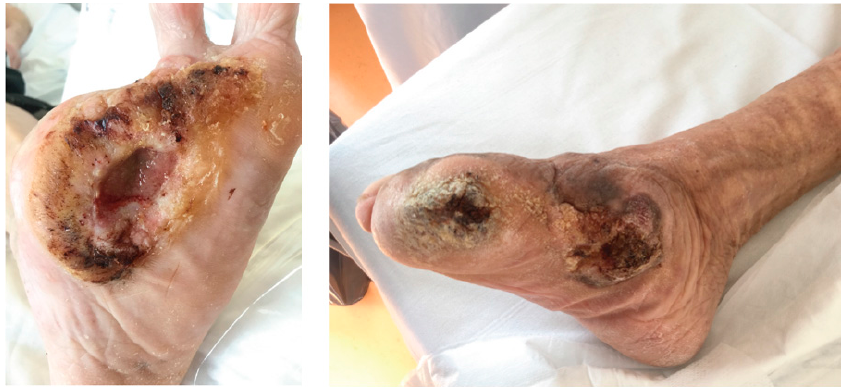
Figure 2. General findings in squamous cell carcinoma in DFU.